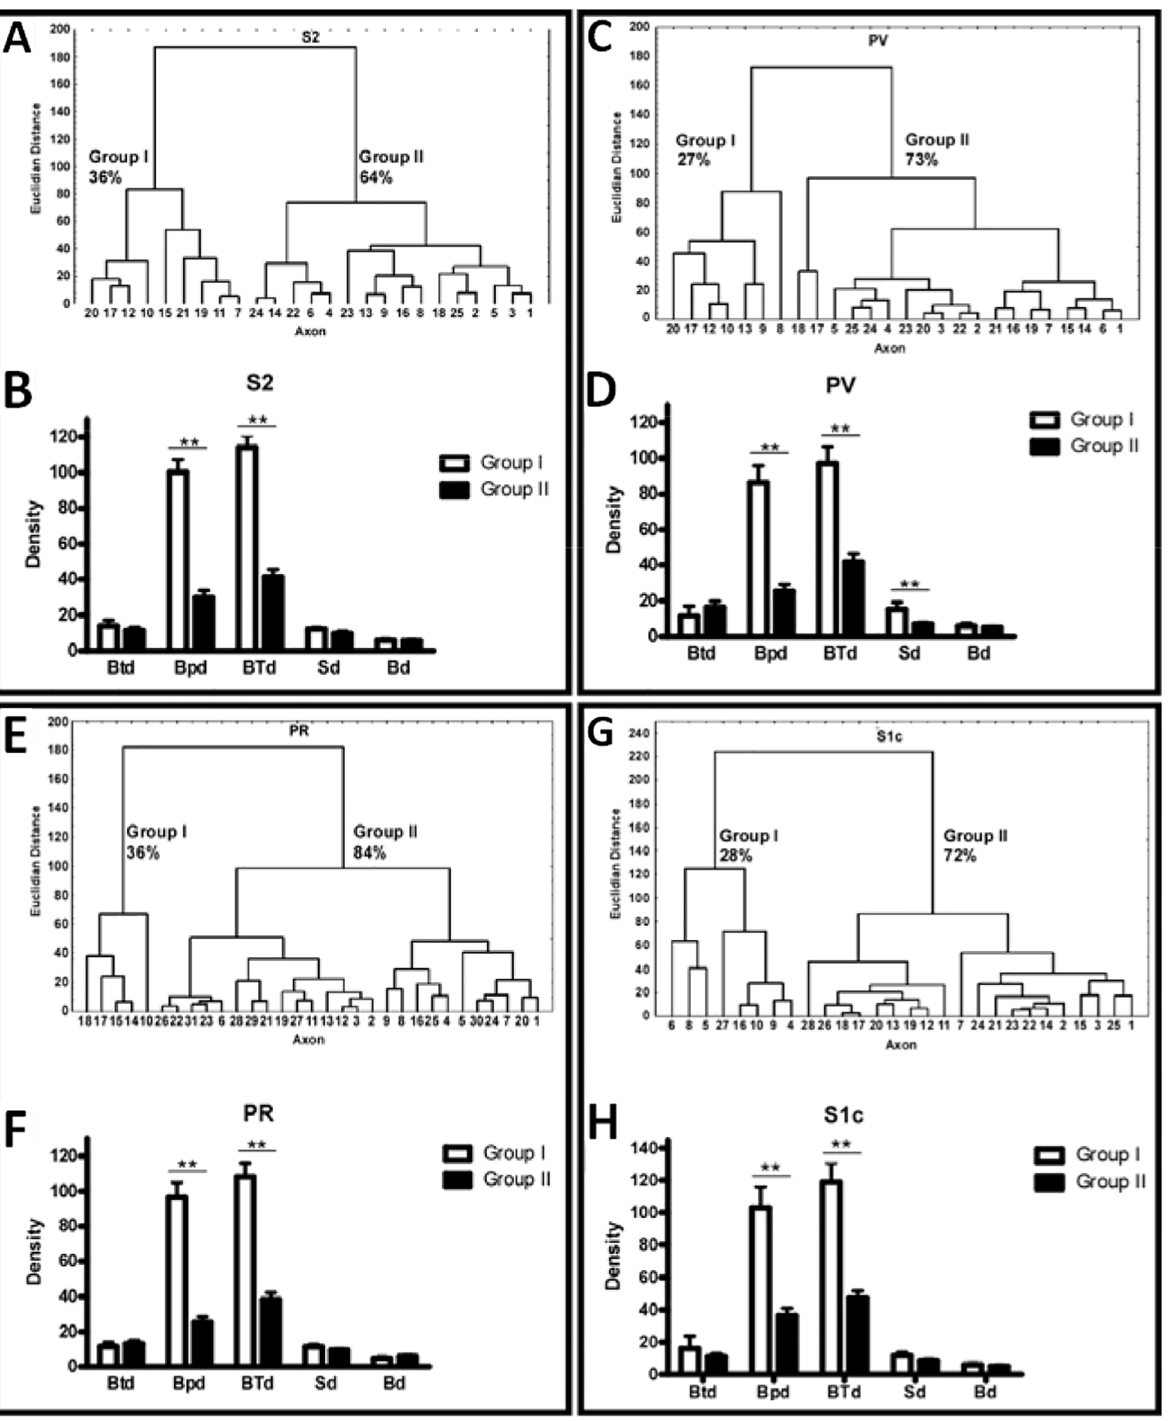
Figure 5 . Hierarchical cluster analysis (HCA) dendrogram showing that feedforward axon terminals from S1 can be separated into two groups (I and II) in secondary somatosensory area (S2) ( A , B ), parietal ventral area (PV) ( C, D ), parietal rhinal area (PR) ( E , F ) and contralateral primary somatosensory area (S1c) ( G , H ). The variable that most contributed to the distinction between groups was the density of boutons terminaux (Btd) (*P o 0.05, ANOVA-Tukey post hoc test). Sd: segment density per millimeter; Bpd: en passant boutons; Bd: bifurcation density per millimeter; BTd: Bpd + Btd Braz J Med Biol Res | doi: